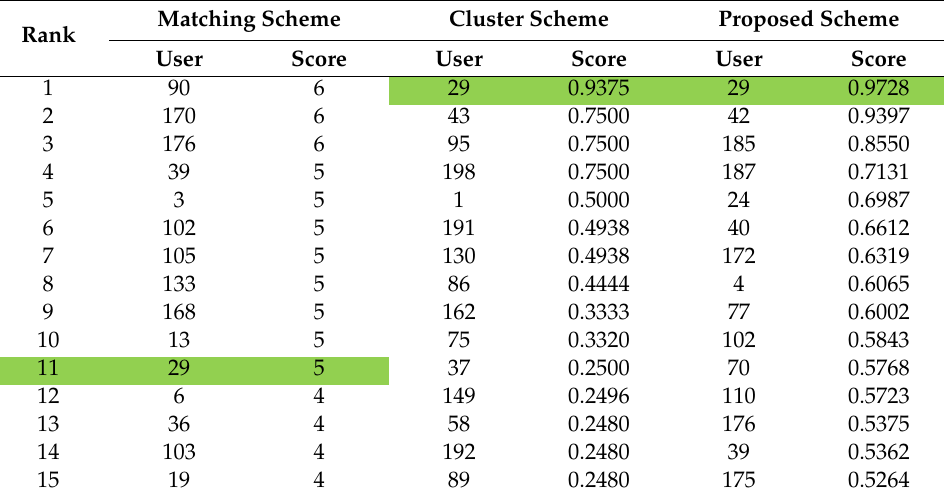
Table 3. Expert finding